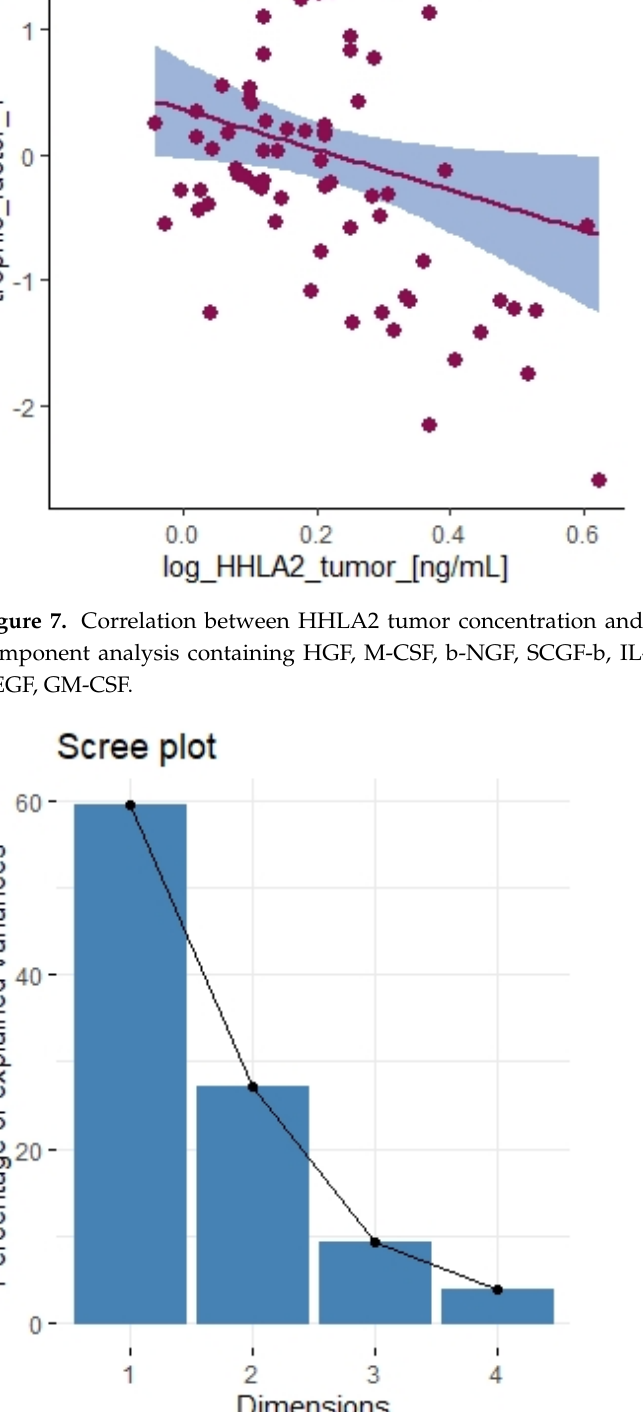
Figure 8. Scree plot of principal component analysis containing antitumor cytokines: IL-1a, IL-12, IL-13, TNF-a. Scree plot shows the proportion of overall variance explained by each individual principal component (factor).